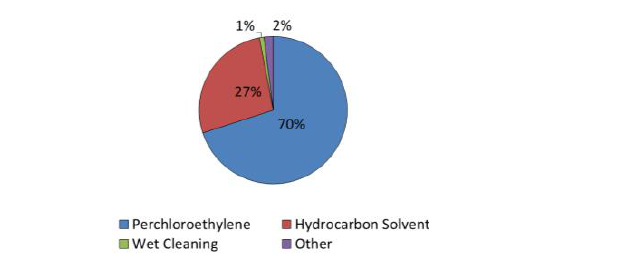
Figure 1. Relative chemical usage by dry cleaners in the United